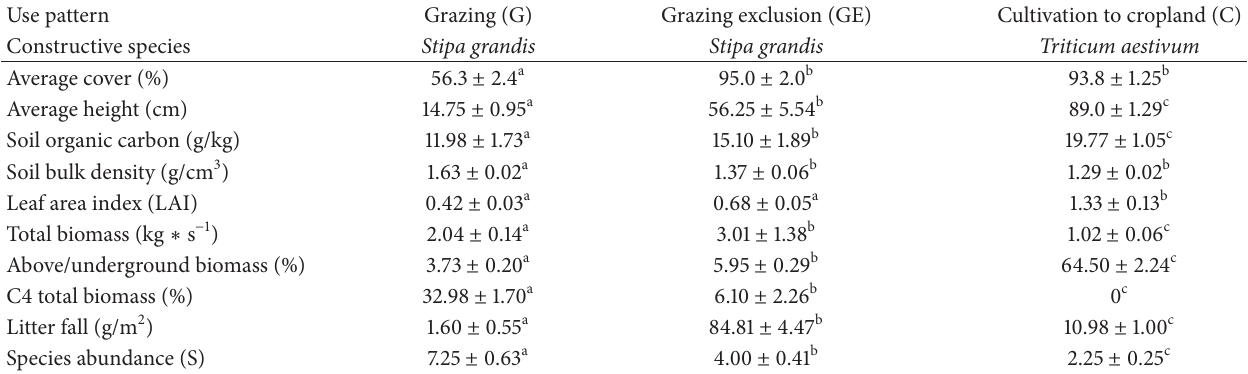
Table 2: Community characteristics of the three land